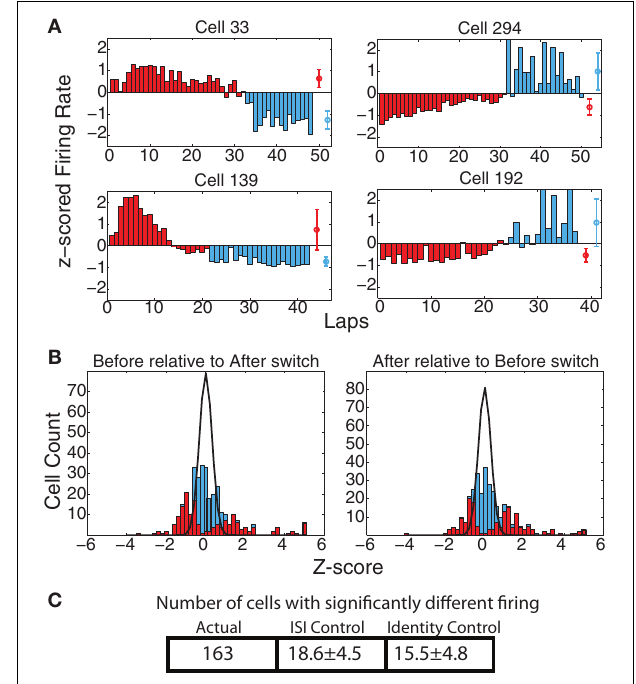
FIGURE 5 | (A) Examples of cells with strong changes in firing rate on laps before and after the switch. Red bars indicate laps before the switch, blue bars laps after the switch. Red and blue circles represent average firing rates over both types of laps. (B) z after (before) and z before (after) comparisons. Bars indicate overall distribution, with red bars indicating cells found to have a significant firing difference by KS test. Black line indicates expected distribution from ID shuffle. (C) Number of cells with significantly different firing (by KS test of the distribution of firing rates on laps before the switch compared to after the switch) relative to expected number of cells from two control conditions with inter-spike-intervals (ISI) or lap identity (ID) randomly